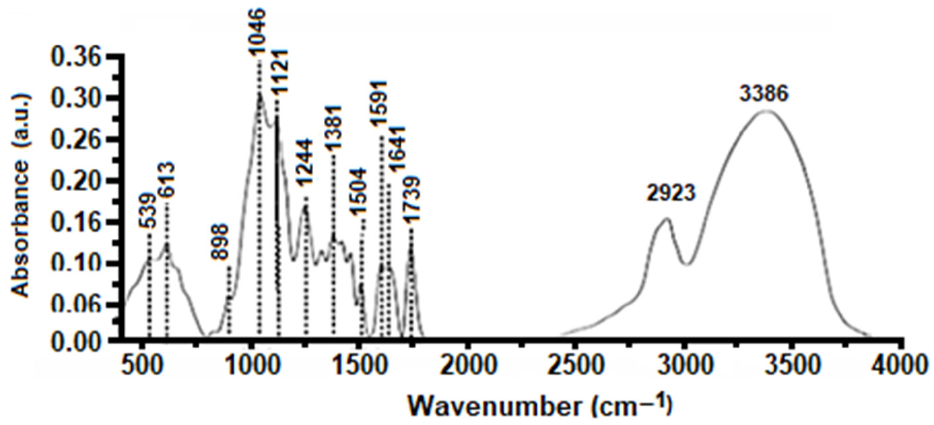
Figure 1. FTIR analysis of AS.